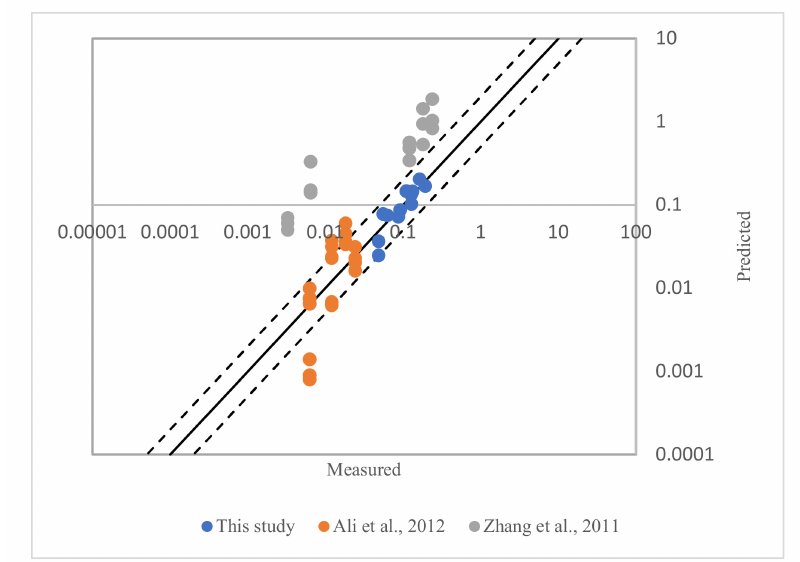
Figure 5. The plot of calculated against measured sediment transport